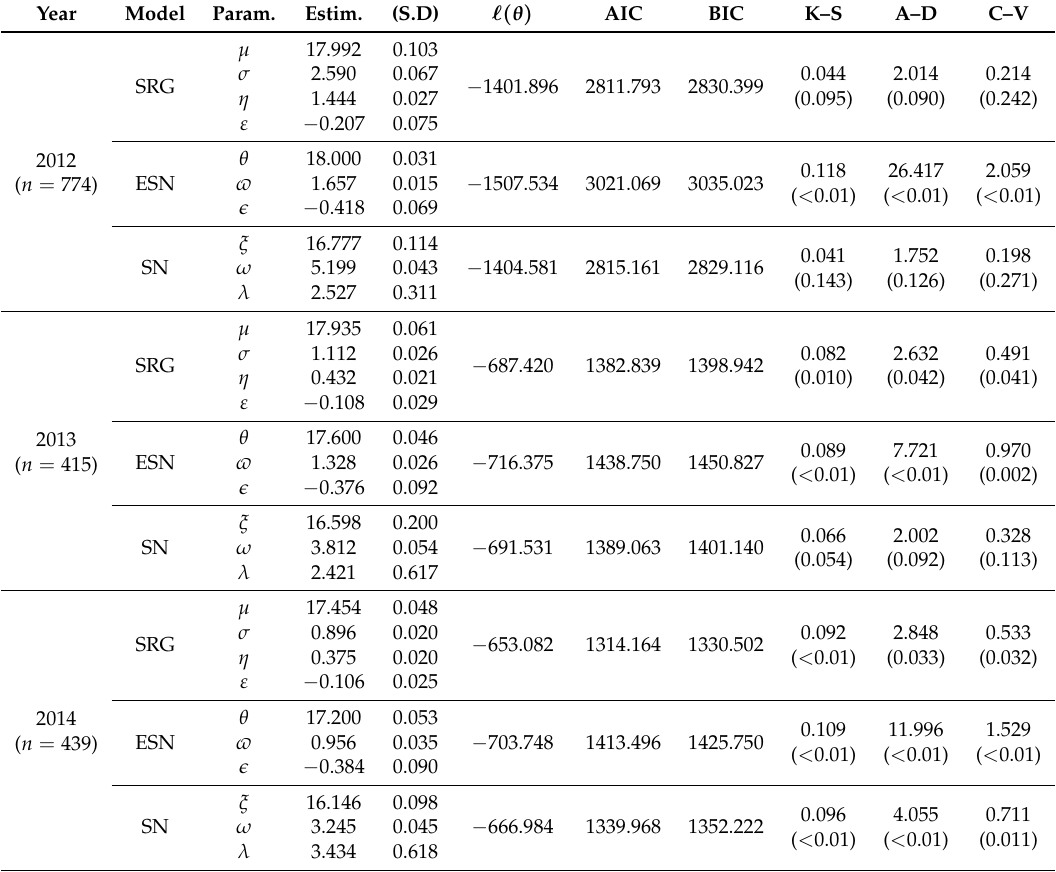
Table 1. Parameter estimates and their respective standard deviations (SD) for SST by year based on SRG, epsilon-skew-normal (ESN) and skew-normal (SN) models. For each model, log-likelihood function (cid:96) ( θ ) , θ = ( µ , σ , η , ε ) , Akaike’s (AIC) and Bayesian (BIC) information criteria, and goodness-of-fit tests (Kolmogorov–Smirnov (K–S), Anderson–Darling (A–D), and Cramer–von Mises, (C–V)) are also reported with respective p-values in